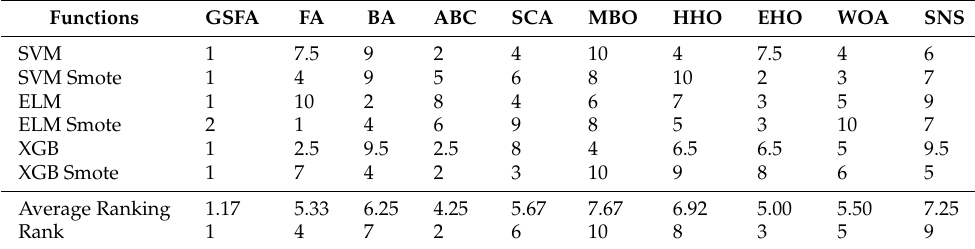
Table 19. Friedman test ranks for the compared algorithms.